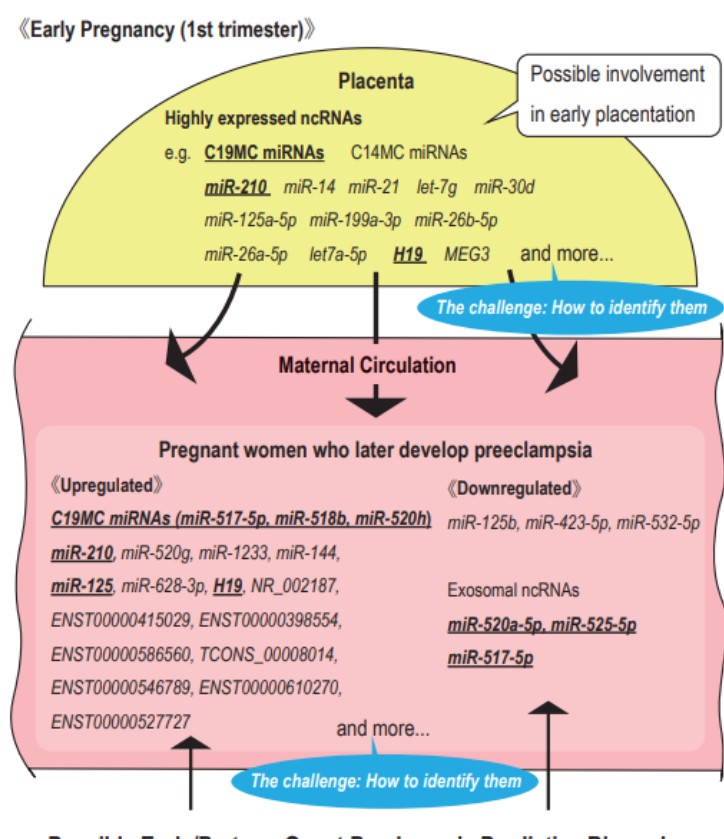
Figure 2. Possible predictive biomarkers for early/preterm onset preeclampsia. Highly expressed non-coding RNAs in the placenta or extravillous trophoblasts in early pregnancy may be involved in early placentation and in the pathogenesis of early-onset and preterm onset preeclampsia (EOPE and POPE). Some of these ncRNAs are also detected in the maternal circulation. ncRNAs that show significant differences in their expression levels and patterns in early pregnancy between normal pregnant women and those who later develop EOPE or POPE have potential as predictive biomarkers for EOPE or POPE in early pregnancy. Under bar: ncRNAs that are highly expressed in the early placenta and show significantly altered expression levels in the peripheral blood of early pregnant women who later develop